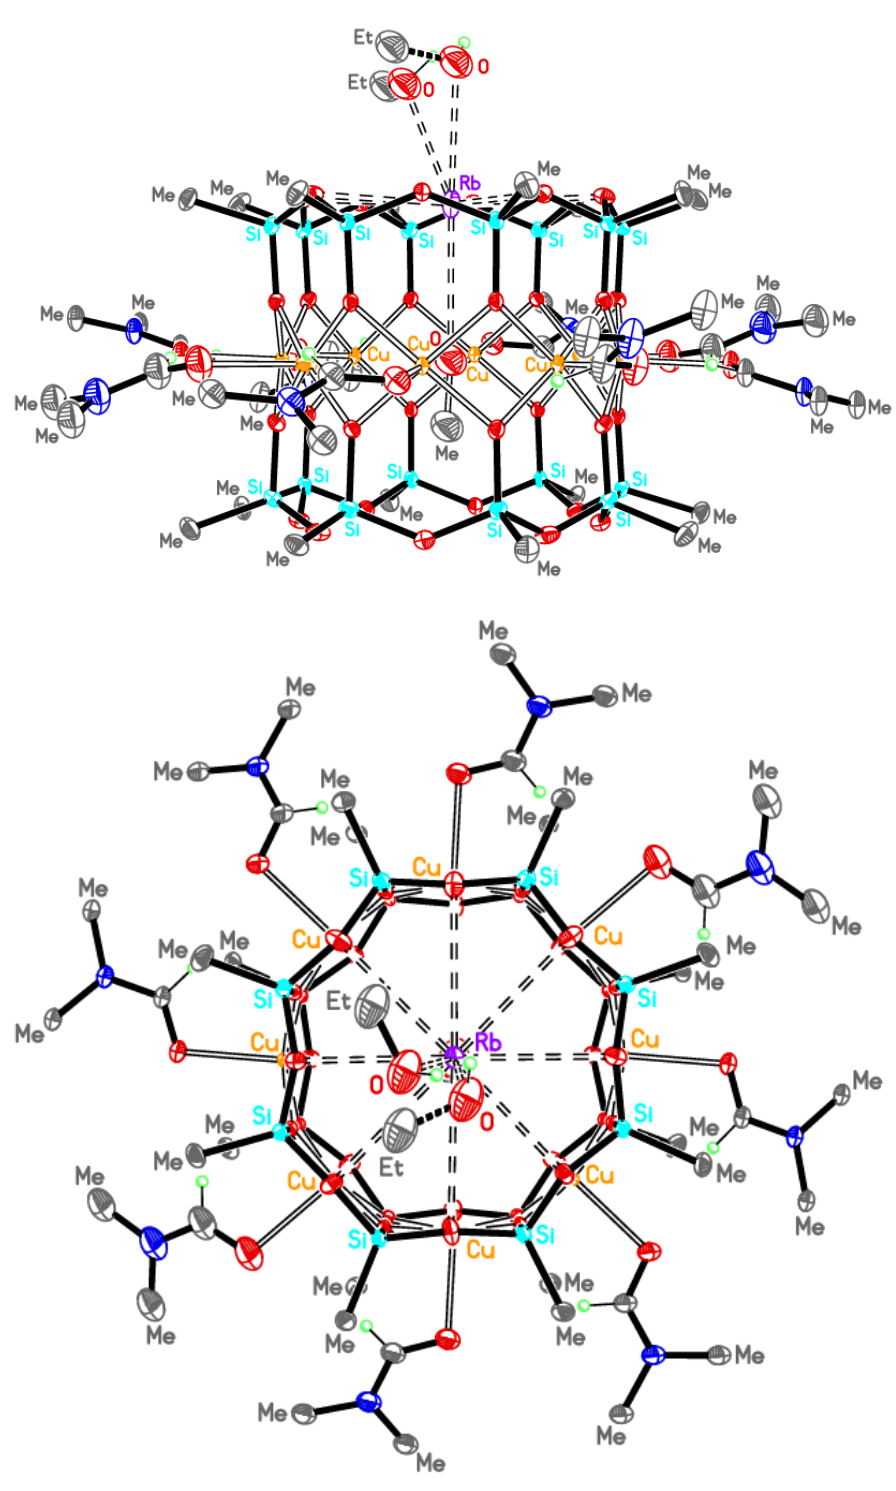
Figure 5. Two projections of molecular structure of complex [(MeSiO 2 ) 8 ] 2 Cu 8 (DMF) 8 Rb (MeO) (EtOH)] 3 .